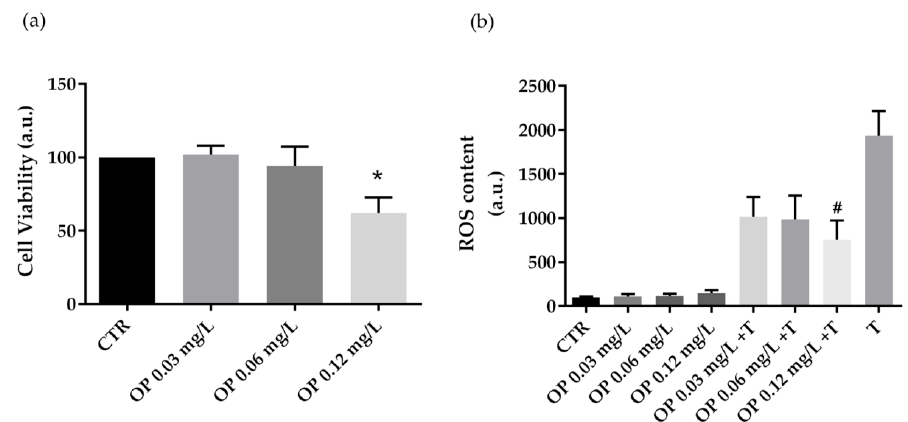
Figure 2. Cell viability ( a ) and ROS content ( b ) in HCT8 cells exposed to olive pomace (OP). ( a ) Cells were left under basal condition or exposed to increasing concentrations (0.03 mg L − 1 , 0.06 mg L − 1 , and 0.12 mg L − 1 of phenols) of OP and were stained with crystal violet solution. Data are shown as means ± S.E.M. of 3 independent experiments and analyzed by one-way ANOVA followed by Dunnett’s multiple comparisons test (* p < 0.05 vs. CTR). ( b ) ROS content was measured using dihydrorhodamine-123 fluorescence in cells treated as previously described. As a positive control, cells were treated with tert-butyl hydroperoxide (tBHP). Data are shown as means ± S.E.M. of 3 independent experiments and analyzed by one-way ANOVA followed by Dunnett’s multiple comparisons test. (# p < 0.05 vs. tBHP).